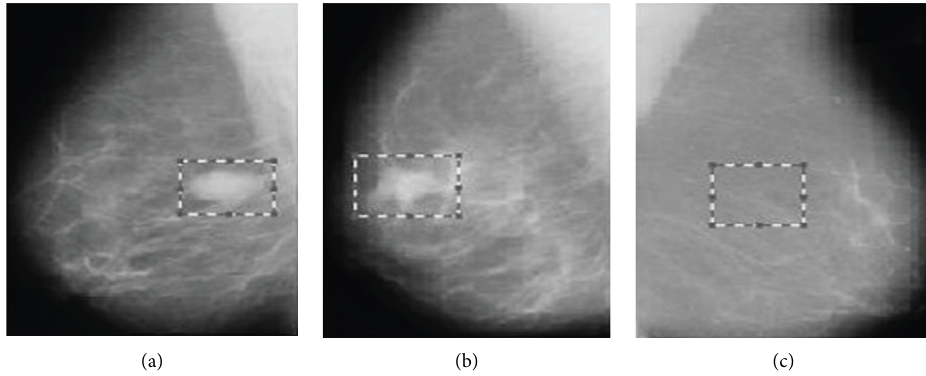
Figure 4: An example of ROIs within Mammogram images. (a) Benign ROI. (b) Malignant ROI. (c) Normal ROI.